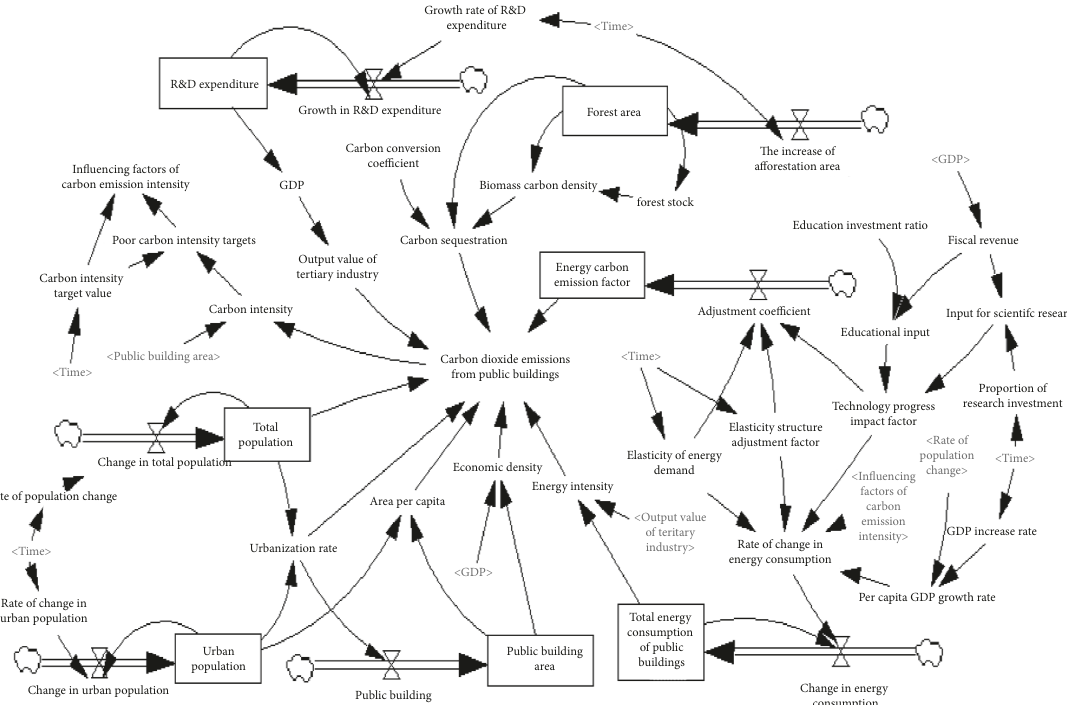
Figure 2: Carbon emission system stock flow diagram of public